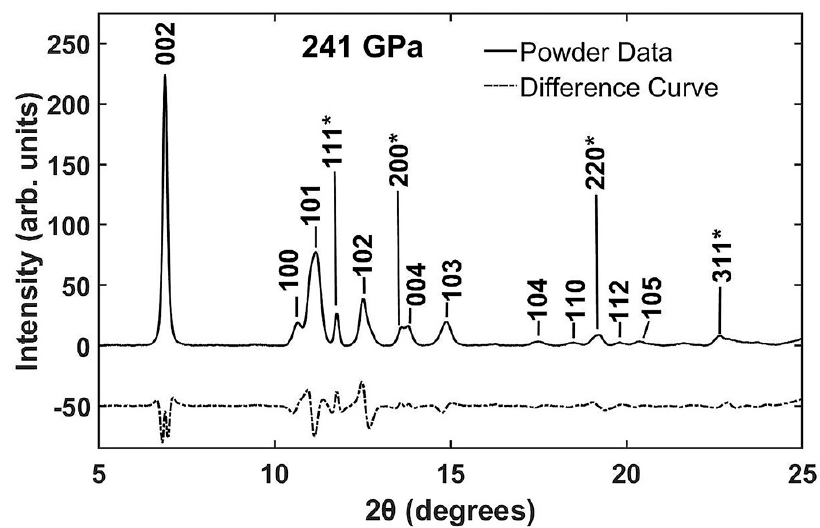
Figure 2. Powder diffraction of ReB 2 indexed to a hexagonal phase at a pressure of 241 GPa. Shown below the data curve is the difference curve as a result of Rietveld refinement. The platinum peaks (labeled with asterisk *) were indexed to a face-centered cubic phase and its measured volume was used in the calculation of pressure.